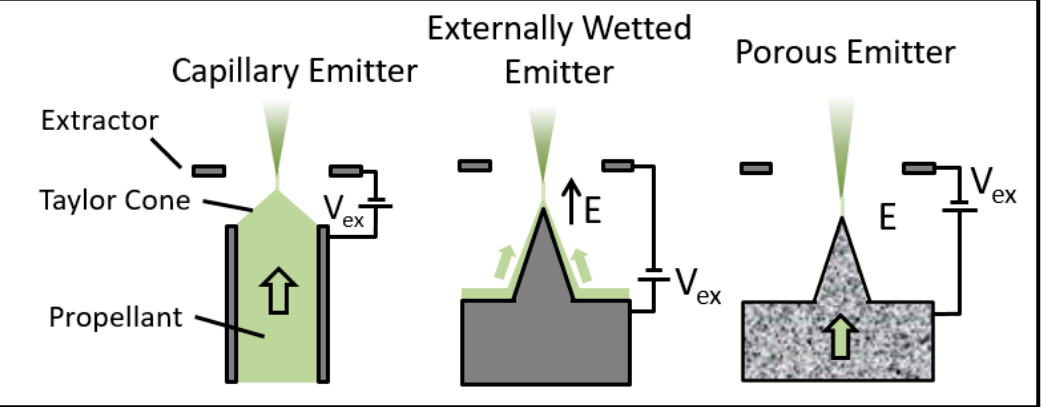
Figure 1. Summary of emission modes.